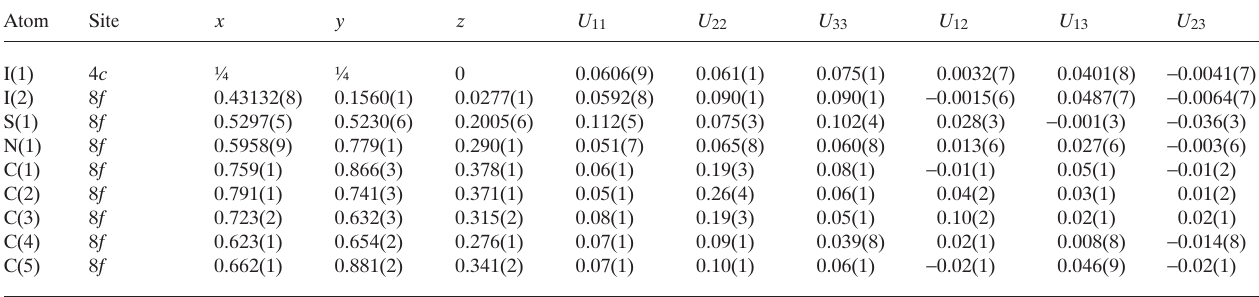
Table 3. Atomic coordinates and displacement parameters (in Å 2 )